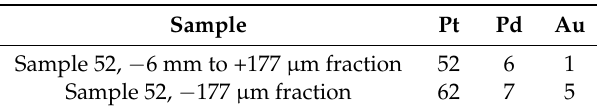
Table 1. Soil sample assay (ppm).